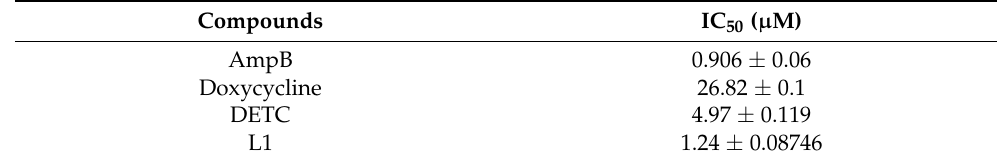
Table 2. Antiparasitic activity of the compounds against L. amazonensis promastigotes, as performed by resazurin assay. Promastigotes were treated after 24 h and the IC 50 was determined. Each value expresses the mean of three experiments performed in triplicate ± standard deviation, using a regression curve.